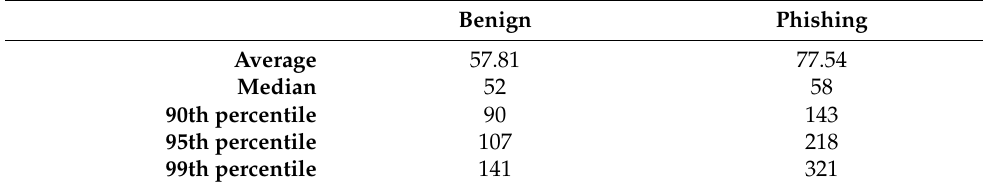
Table 2. Statistical analysis of URL length over the training